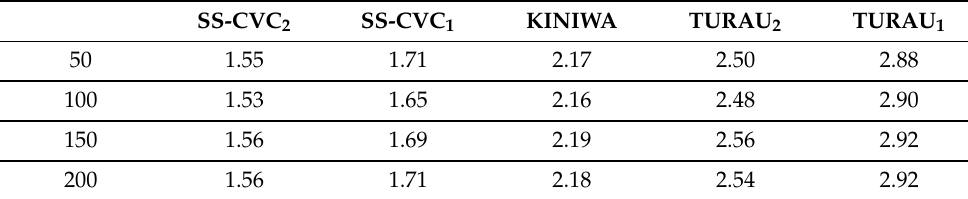
Figure 13. VC Weight of algorithms on the weighted networks: ( a ) VC weight against node count on the fixed average degree 5; ( b ) VC weight against node count on the fixed network size 150. Table 1. Approximation ratios of algorithms (Avg. degree = 3).